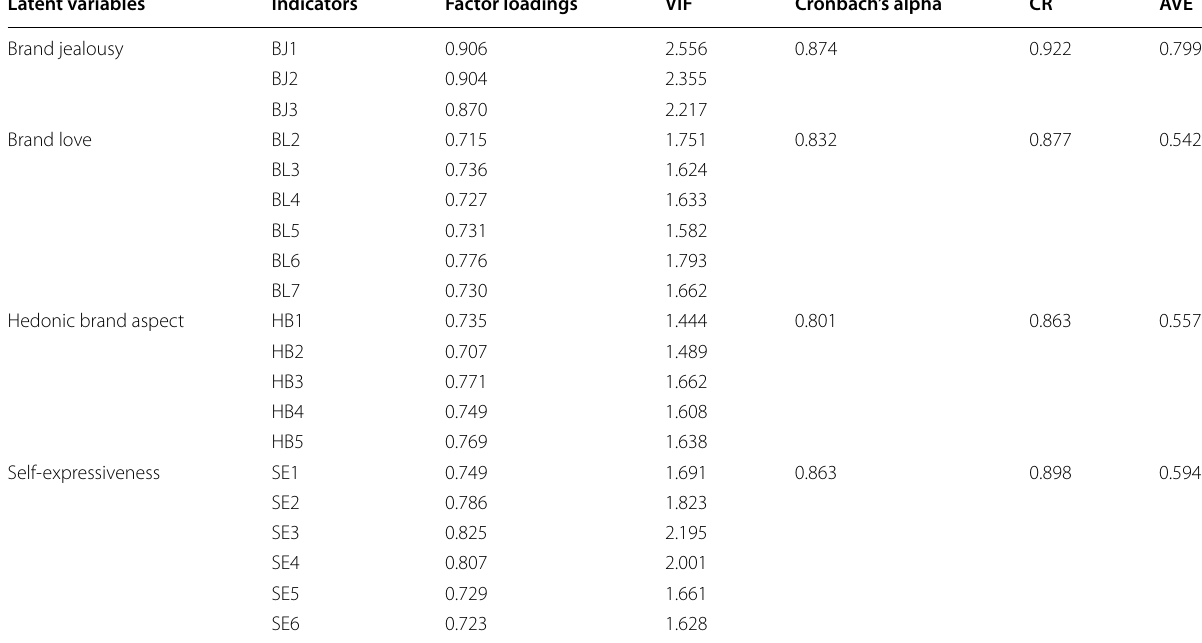
Indicators reliability: Loadings; CR Composite reliability; AVE Average variance extracted